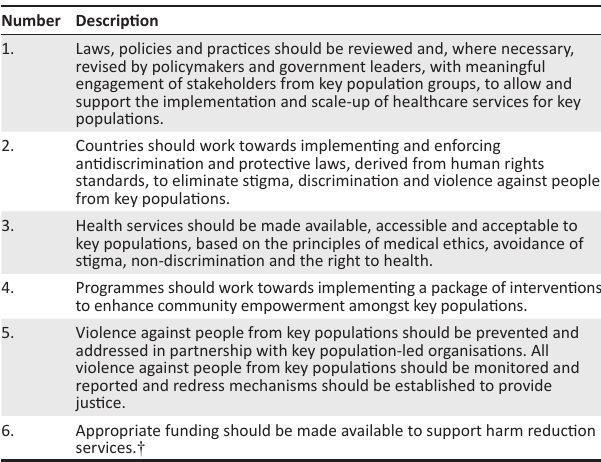
TABLE 8: Critical enablers.